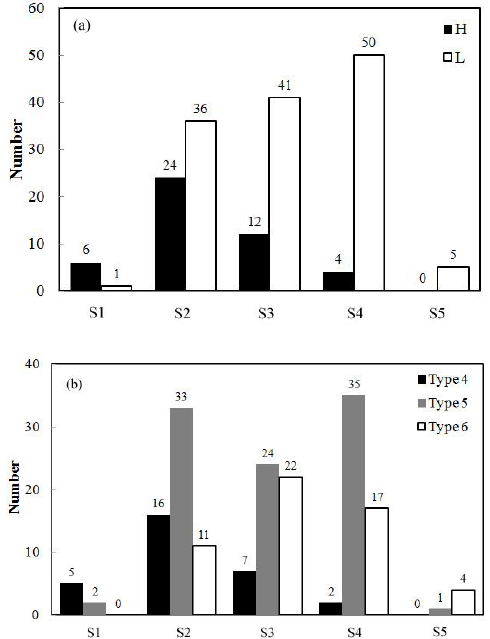
Figure 6. Histograms of shock degrees of Grove Mountain chondrites: ( a ) chemical groups, and ( b ) petrographic types .